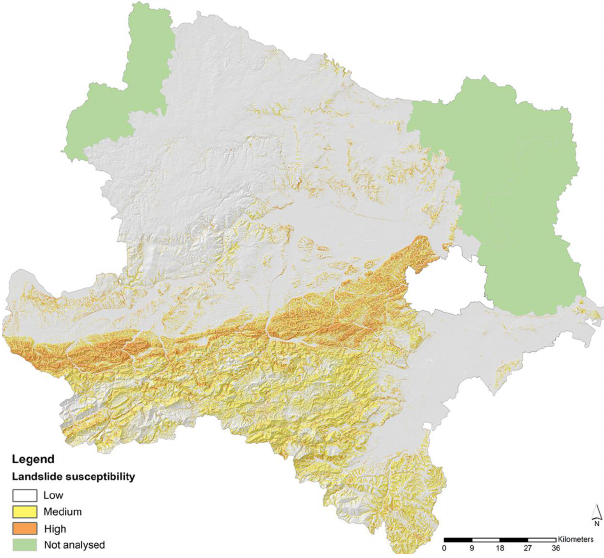
Figure 4. Resulting classified landslide susceptibility map for Lower Austria. Data source: 2 Fig. 4. Resulting classified landslide susceptibility map for Lower LiDAR-DTM hillshade - Provincial Government of Lower Austria. 3 Austria. Data source: LiDAR-DTM hillshade – Provincial Govern- ment of Lower